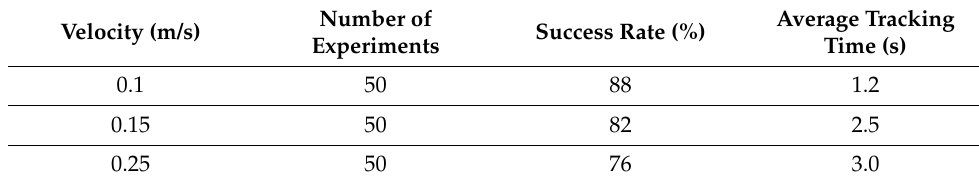
Figure 11. Tracking image. Table 3. Tracking and Grasping results of uniform linear moving target.